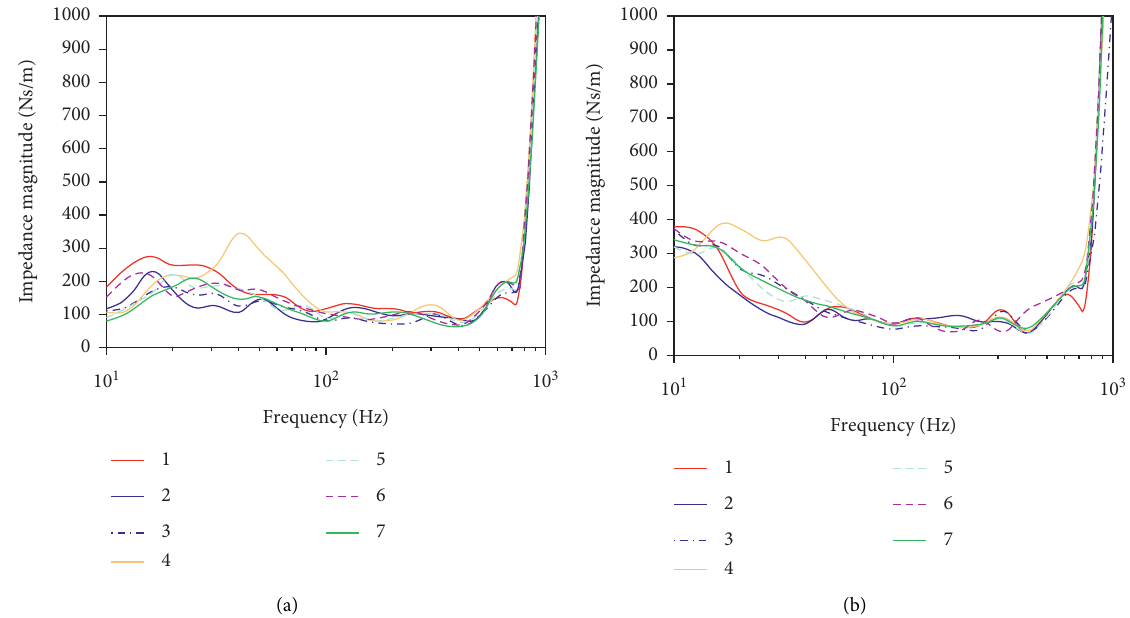
Figure 7: Amplitude of mechanical impedance of the hand-arm system for different subjects (5m/s 2 vibration magnitude, 30N grip force, and 10N push force). (a) 90 ° elbow angle. (b) 180 ° elbow